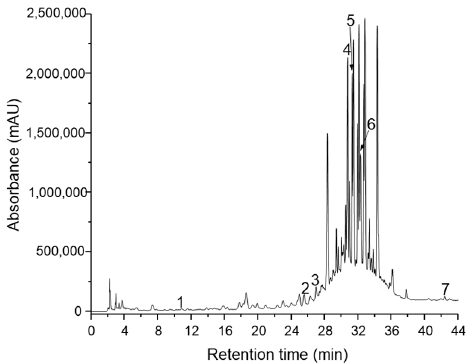
Figure 1. Chromatogram of identified polyphenolic compounds detected in extracts of Laurus nobilis (1- p -OH-benzoic acid; 2-syringic acid; 3-epicatechina; 4-rutin; 5-isoquercitrin; 6-quercetin; 7- kaempferol). Table 1. Total phenolic and flavonoid content of the different plant extracts and sunflower honey. Results are given as mean values of three independent replicates ± standard deviation.